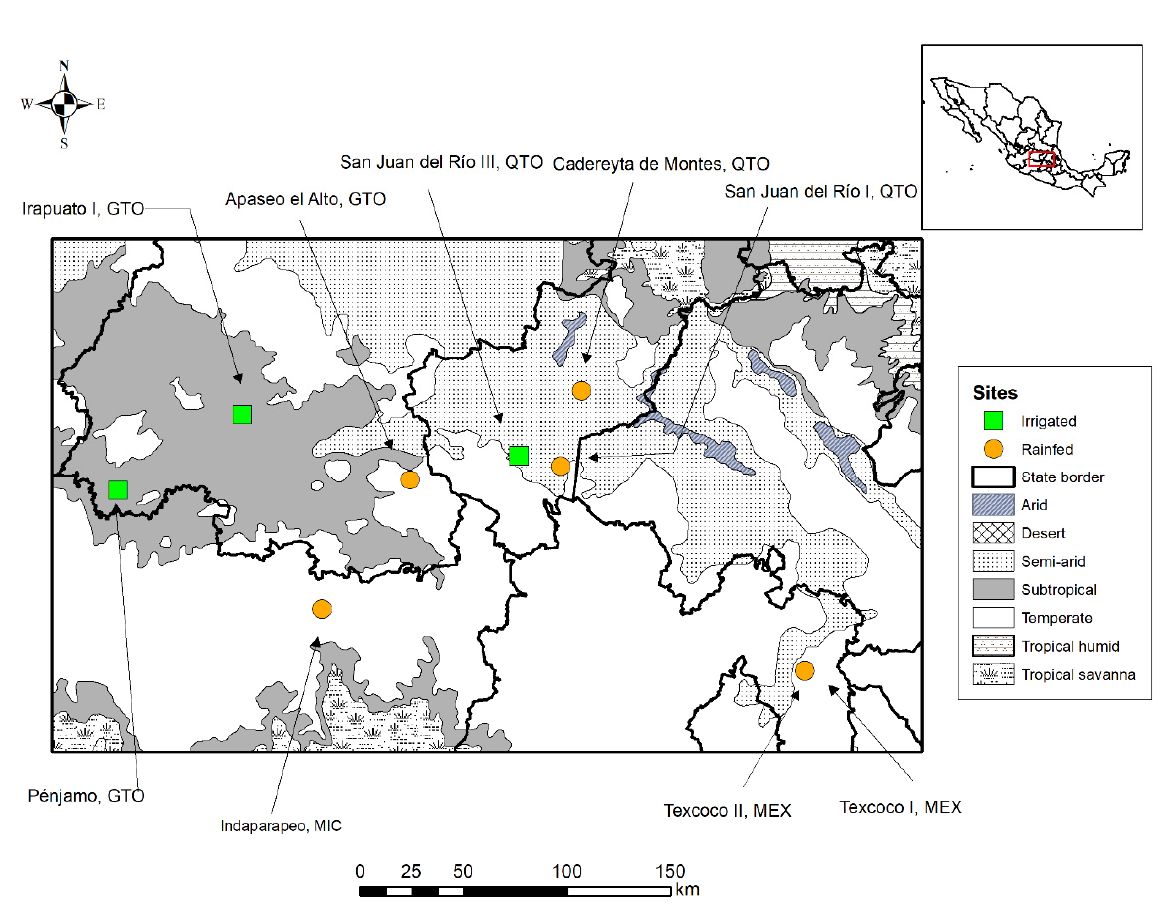
Figure 1. Location of the trials used in this study. Texcoco I and Texcoco II are located at the same research station. Abbreviation of states in site names: GTO = Guanajuato; QTO = Quer é taro; MIC = Michoac á n; MEX = Estado de M é xico. Table 1. Agroecological characteristics of the sites where the study was carried out.